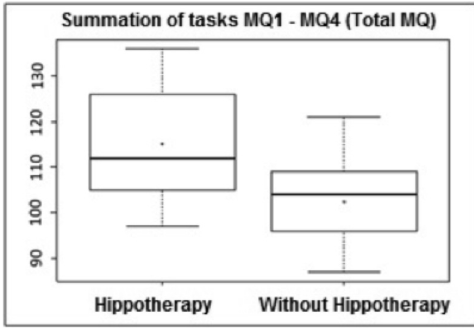
Table 1 - T-Student test with descriptive measures of central tendency and dispersion Variables Average Standard